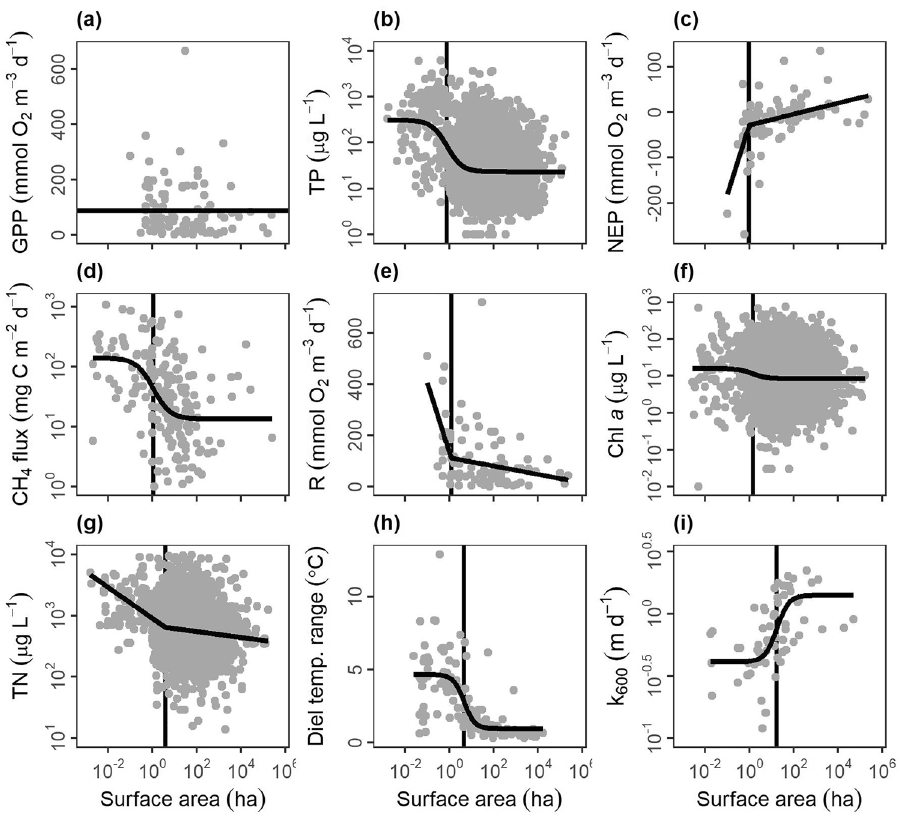
Figure 5. Relationships between lentic waterbody size (excluding wetlands) and ecosystem structure and function metrics: ( a ) gross primary production (GPP), ( b ) total phosphorus concentrations (TP), ( c ) net ecosystem production (NEP), ( d ) methane fluxes (CH 4 flux), ( e ) respiration (R), ( f ) chlorophyll a concentrations (Chl a), ( g ) total nitrogen concentrations (TN), ( h ) diel temperature ranges (DTR), and ( i ) gas transfer piston velocity (k 600 ). Optimal model fits from null, linear, segmented, and logistic curves in bold foreground lines. For nonlinear segmented and logistic models ( b – i ), plots are ordered by boundaries between ponds and lakes, as defined by model breakpoints or inflection points (vertical background